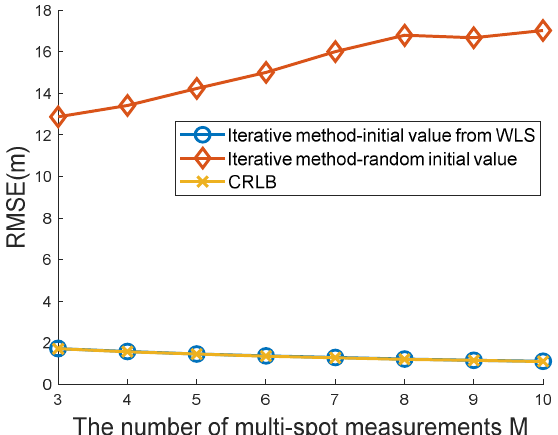
Figure 8. Comparison of the proposed iterative methods with different initial values.